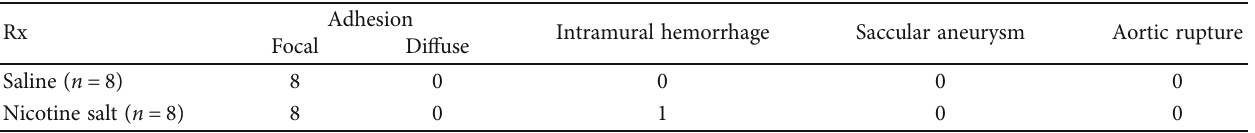
Table 1: Gross pathology detected in mice receiving saline or nicotine salt (34.0mg/kg/day, equivalent to 11.1mg/kg/day of NFB). (a) Pathology in ascending aortas